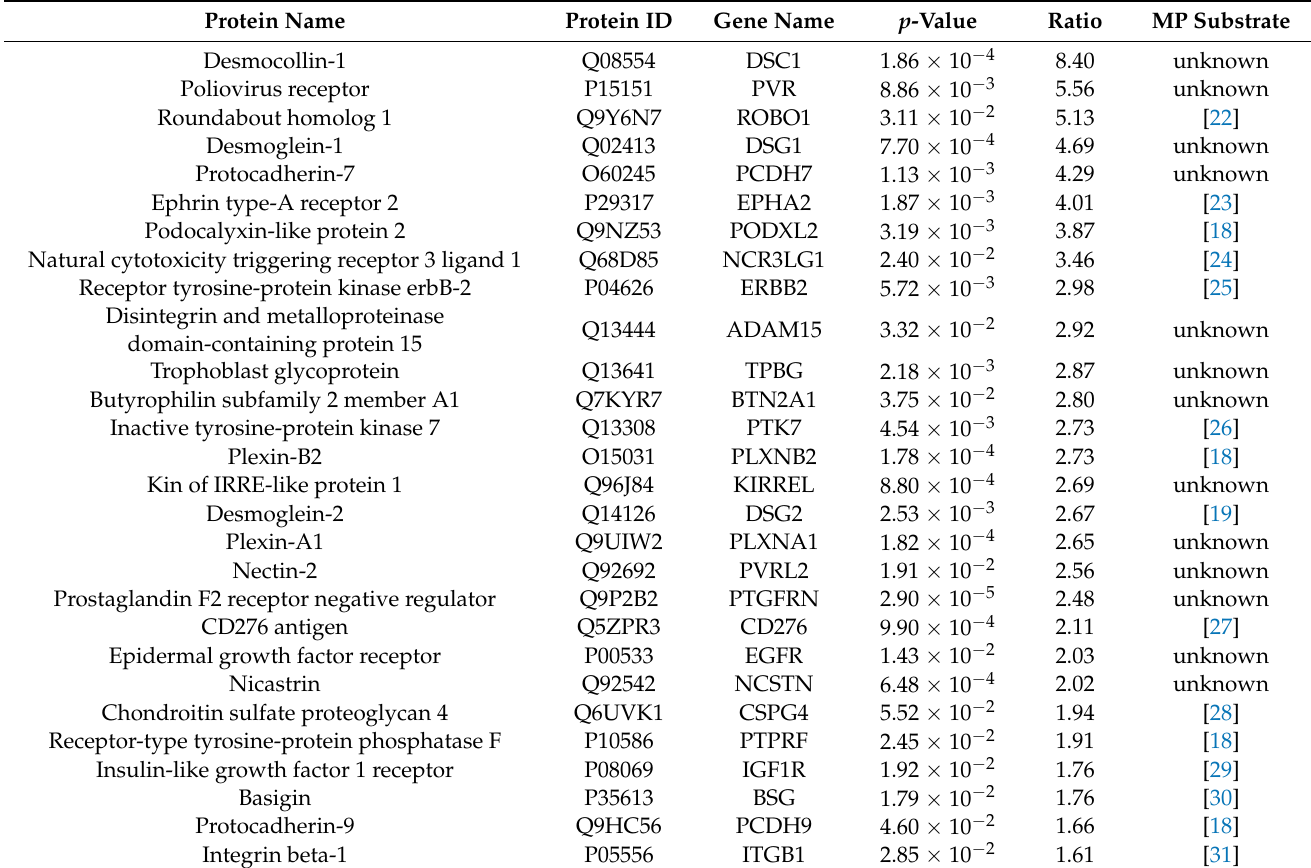
Table 1. Type 1 transmembrane proteins significantly increased at the cell surface of TIMP-3 overexpressing